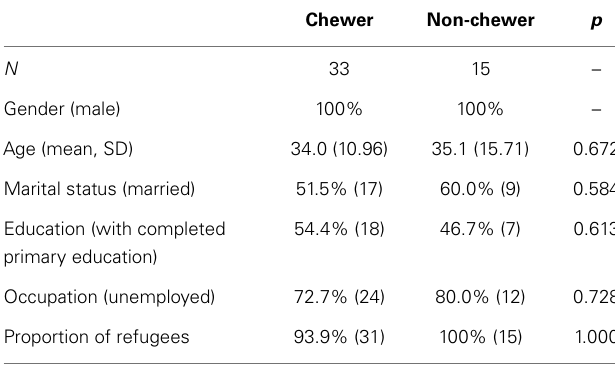
Table 1 | Socio-demographic characteristic of respondents